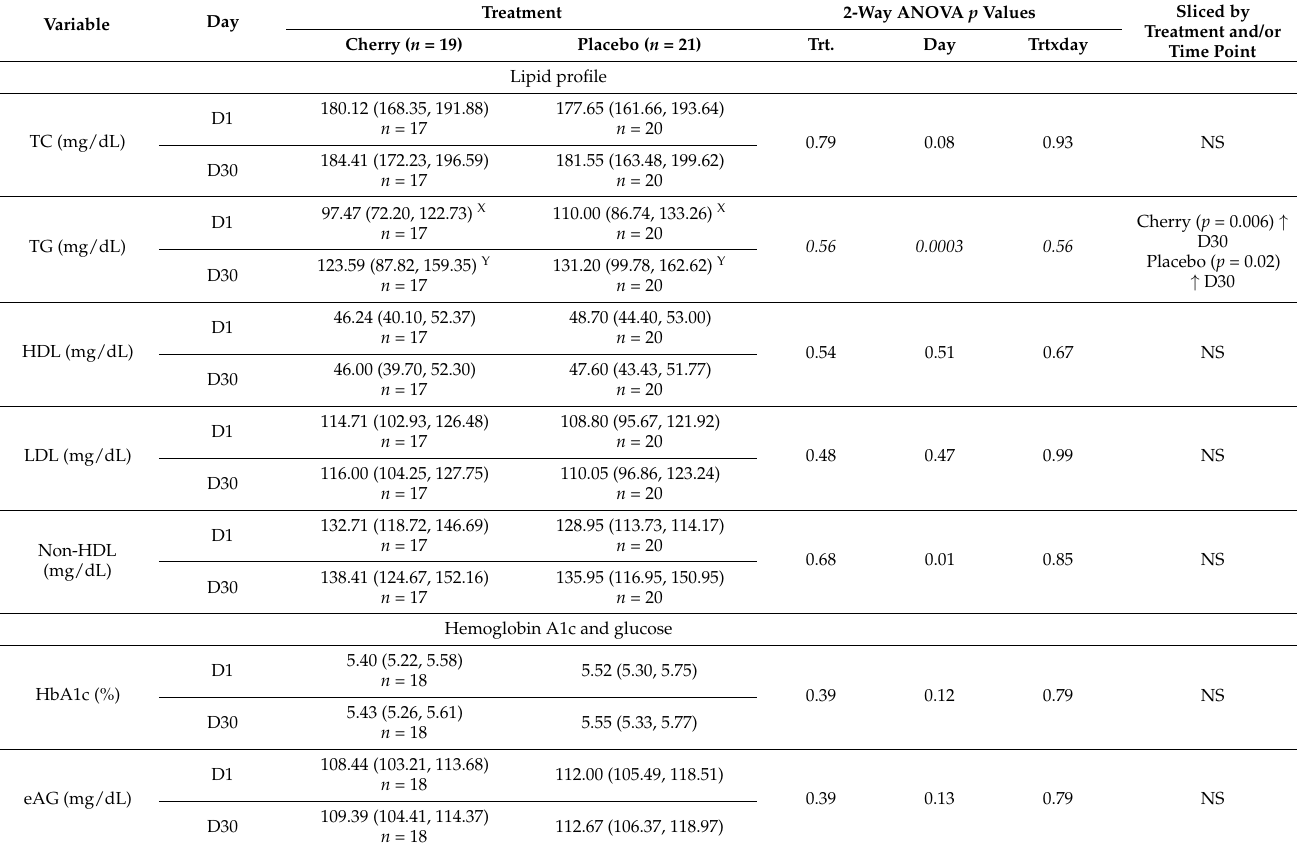
Table 3. Biomarkers of lipid profile, glucose levels and liver